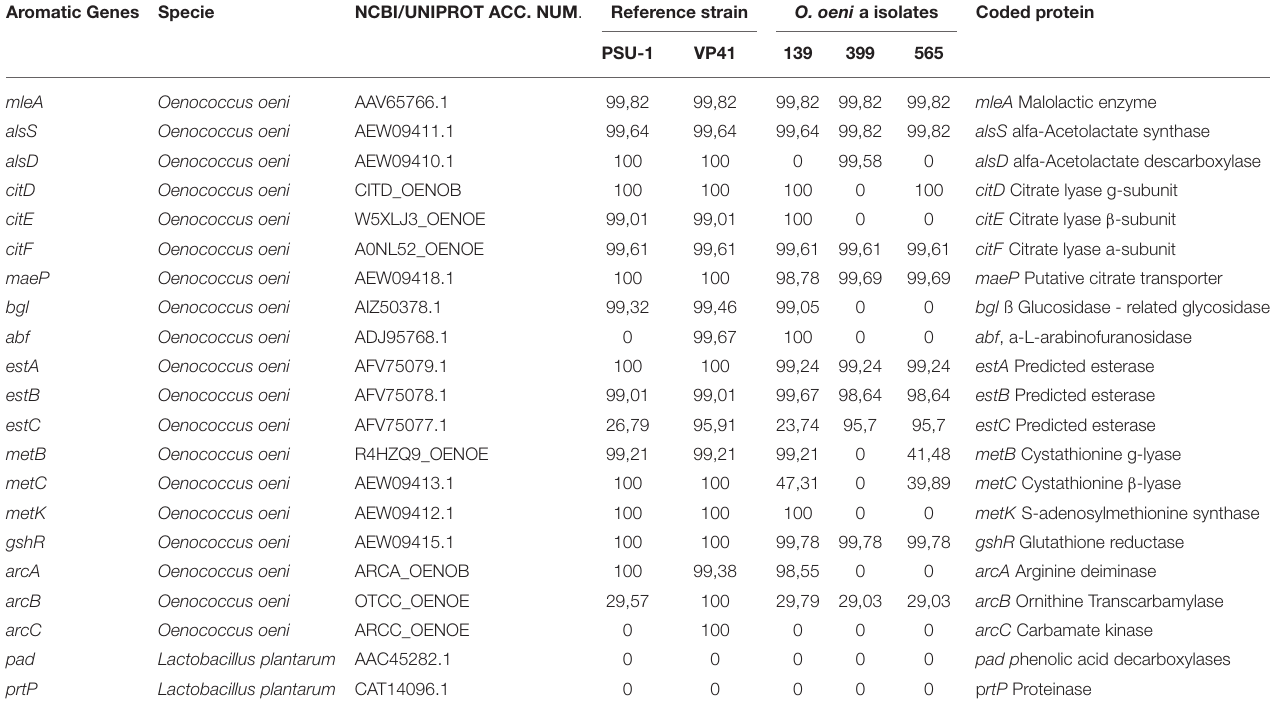
TABLE 5 | Identities of aromatic genes found between autochthonous O. oeni genomes compared with reference strains (VP41 and PSU-1). Aromatic Genes